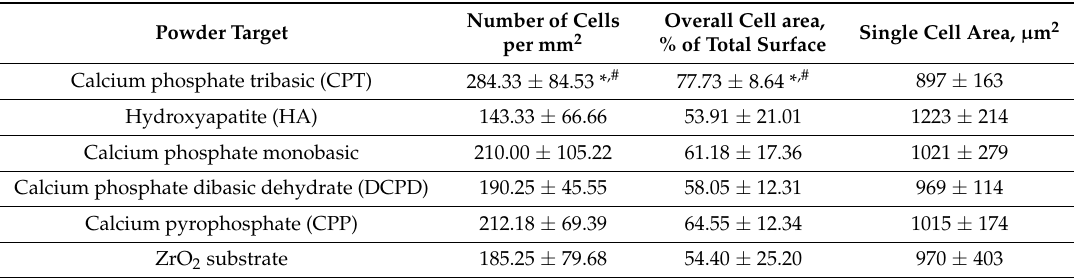
Table 4. Number of adhered MSCs, overall cell area and single cell area on the Ca-P coatings (means ± standard deviations). Vinculin immunostaining.